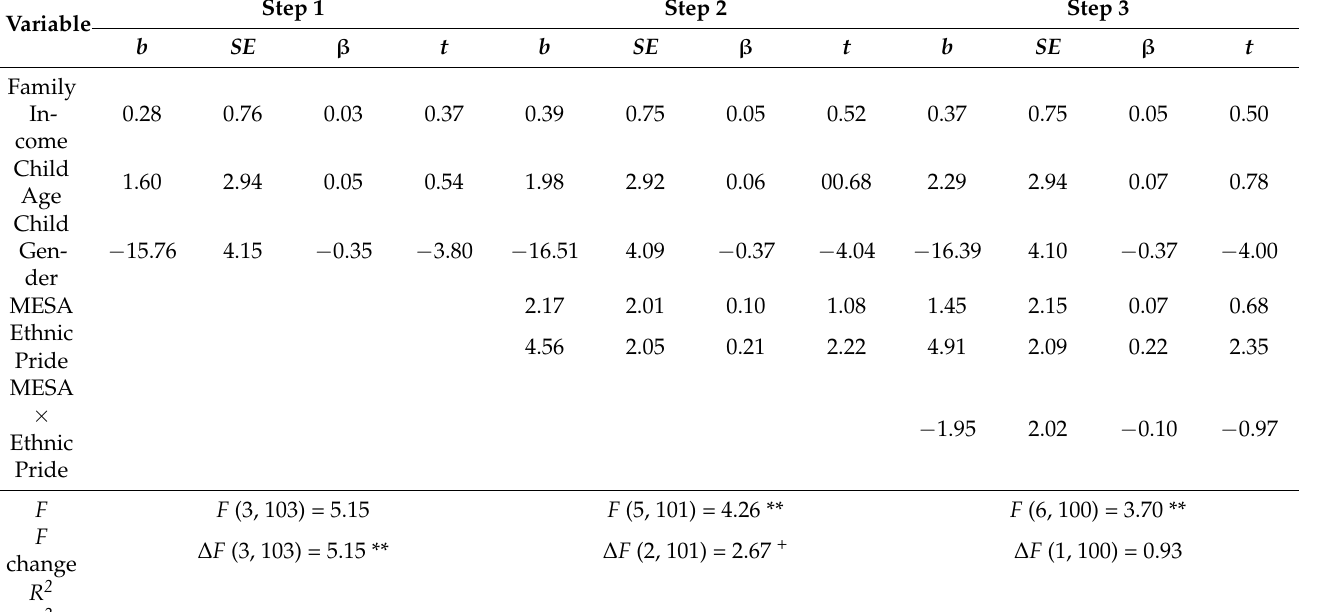
Table 6. Moderated regression analysis of the role of ethnic pride on child BMI